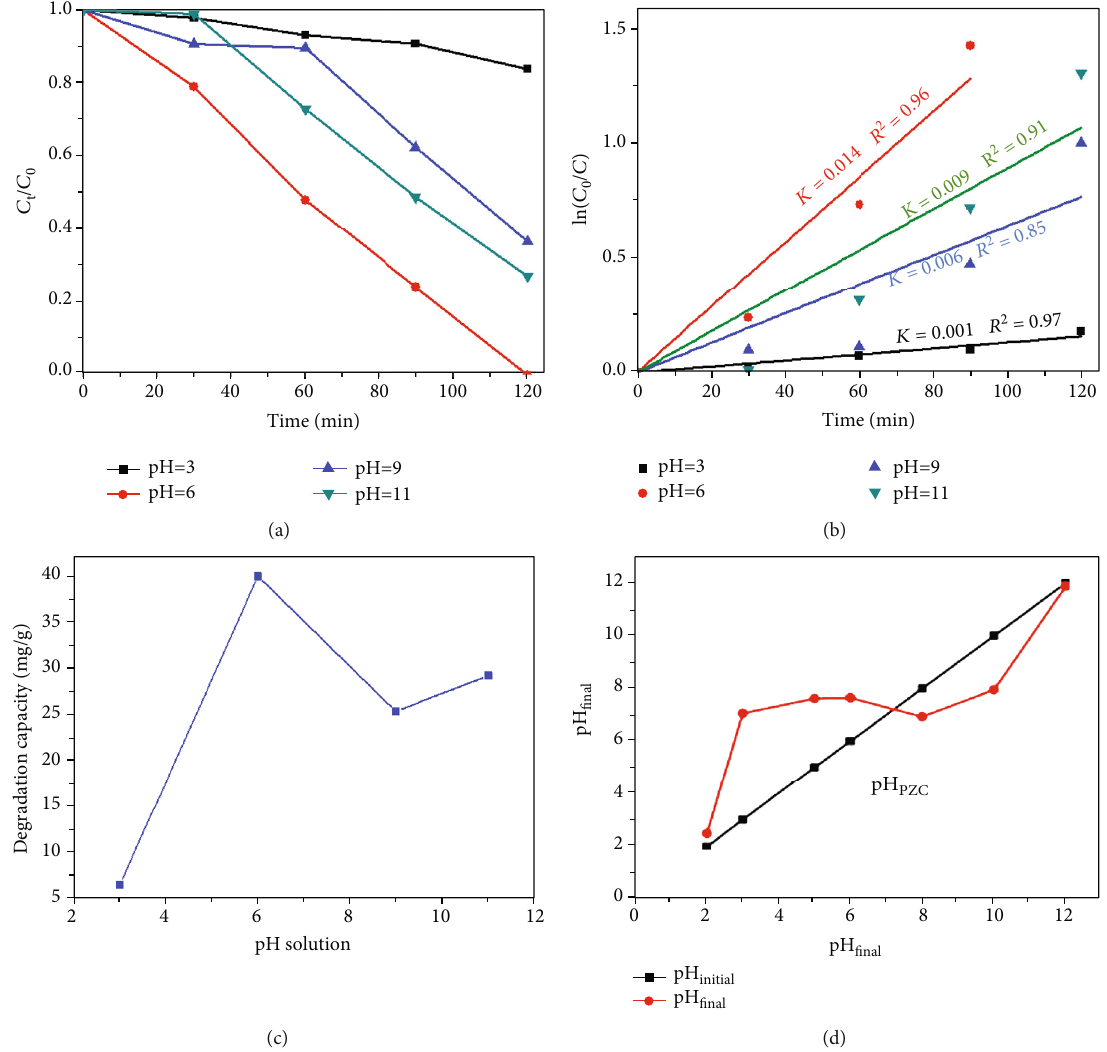
Figure 10: (a) E ff ect of pH solution on the degradation of BPA, (b) the kinetic curves, (c) degradation capacity versus pH solution, and (d) the pH determination of Ag/ZnO. The reaction conditions are as follows: dosage catalyst of 0.05g and BPA concentration of 20 PZC